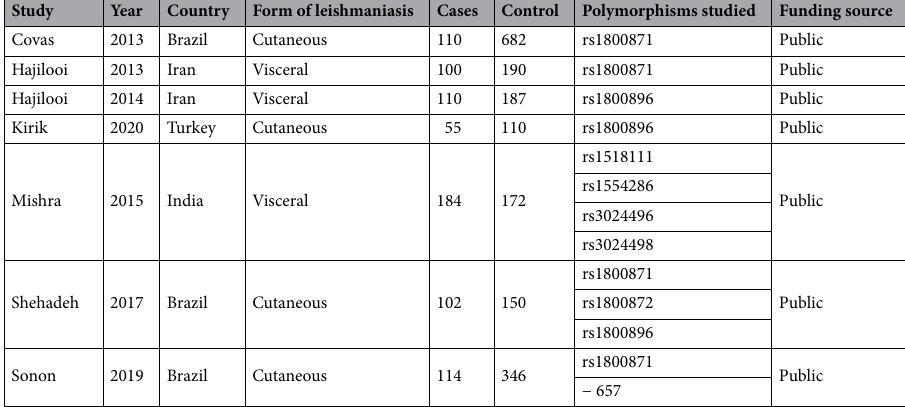
Table 1. Characteristics of studies included in a meta-analysis for the association of IL-10 SNPs and leishmaniasis.